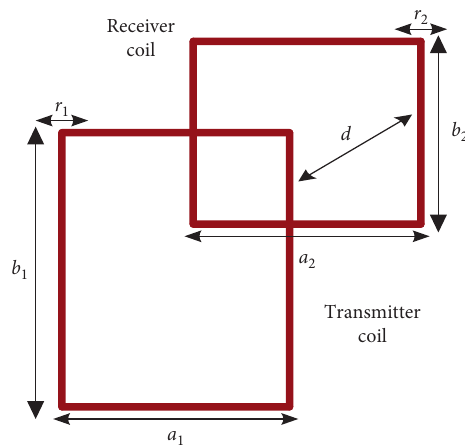
Figure 2: Schematic of the two rectangular coils for M calculation.